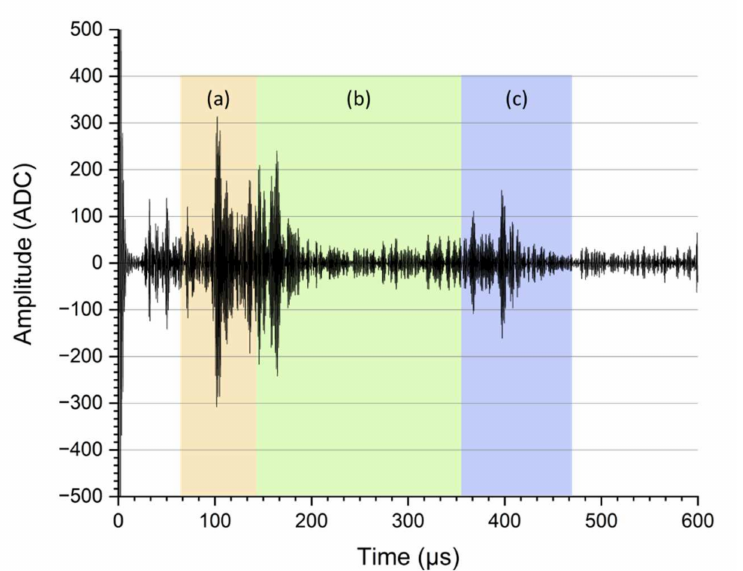
Figure 3. SAW ultrasound signals in transmission mode are divided into three parts for subsequent analysis: ( a ) SAW detection in pitch-catch mode, ( b ) echo detection of SAW, ( c ) longitudinal wave detection in pitch-catch